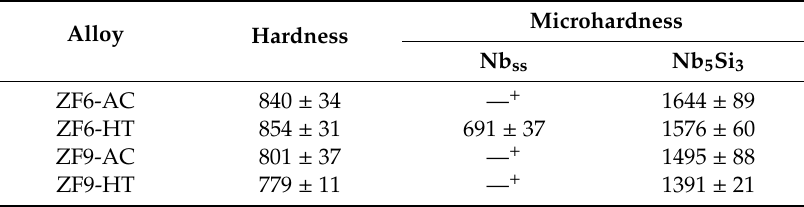
Table 5. Vickers hardness (HV) of the as cast and heat-treated alloys ZF6 and ZF9.